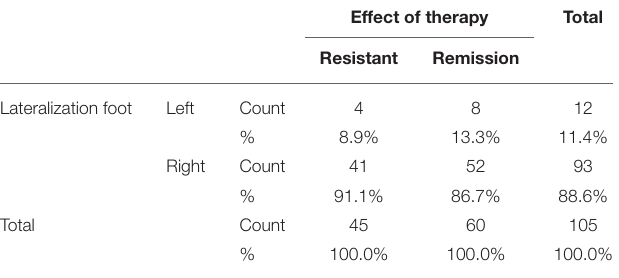
TABLE 4 | Relationship between pure dominance (hand,foot,eye) and cross-dominance with treatment